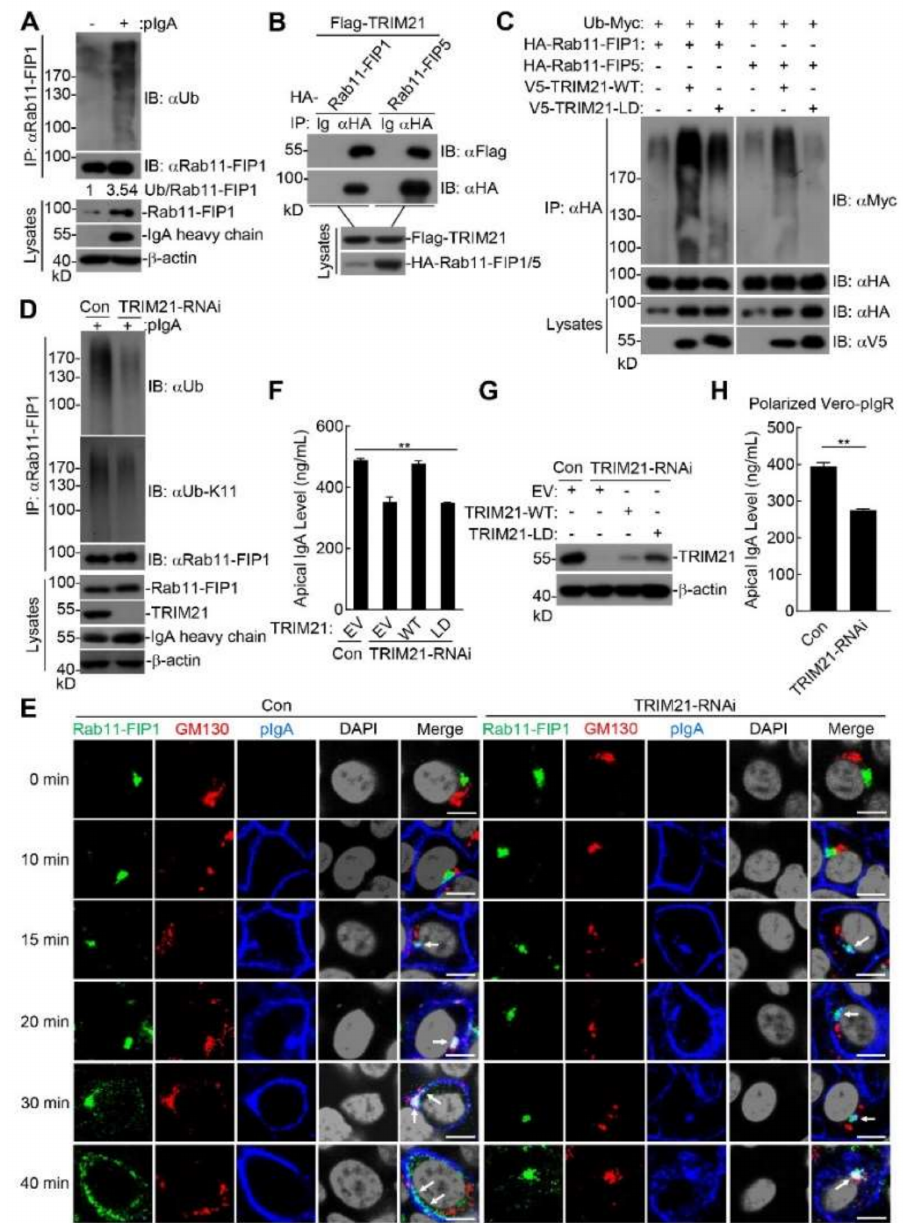
Figure 6. TRIM21 − mediated polyubiquitination of Rab11 − FIP1 and Rab11 − FIP5 is crucial for their ability to facilitate pIgA transcytosis. ( A ) Effects of pIgA transcytosis on the ubiquitination of Rab11 − FIP1. Vero − pIgR cells (4 × 10 5 ) were grown on 24 mm diameter Transwell (0.4 µ m pore) for 3 days. An amount of 80 µ g pIgA was added or not added to the basal chamber for 1 h. The cells (2 × 10 7 ) were harvested for ubiquitination assays with the indicated antibodies. ( B ) The interaction between Rab11 − FIP1, Rab11 − FIP5 and TRIM21 was detected. HEK293T cells (2 × 10 6 ) were co − transfected with the indicated plasmids for 24 h. Coimmunoprecipitation and immunoblotting analyses were performed with the indicated antibodies. ( C ) TRIM21 mediated polyubiquitination of Rab11 − FIP1 and Rab11 − FIP5 was detected. HEK293T cells (2 × 10 6 ) were co − transfected with the indicated plasmids for 24 h. Ubiquitination assays were performed with the indicated antibodies. ( D ) Effects of TRIM21 knockdown on the K11 − linked ubiquitination of Rab11 − FIP1 during pIgA transcytosis. Vero − pIgR cells were transduced with control or the indicated TRIM21 − RNAi plasmids by retroviral − mediated gene transfer to establish stable cell